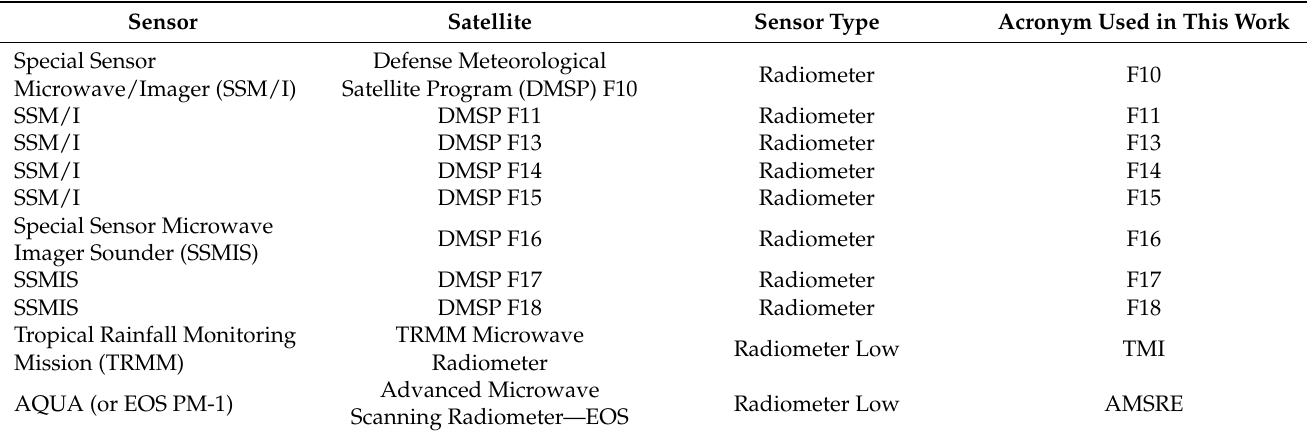
Table 1. Satellites and Sensors included in the